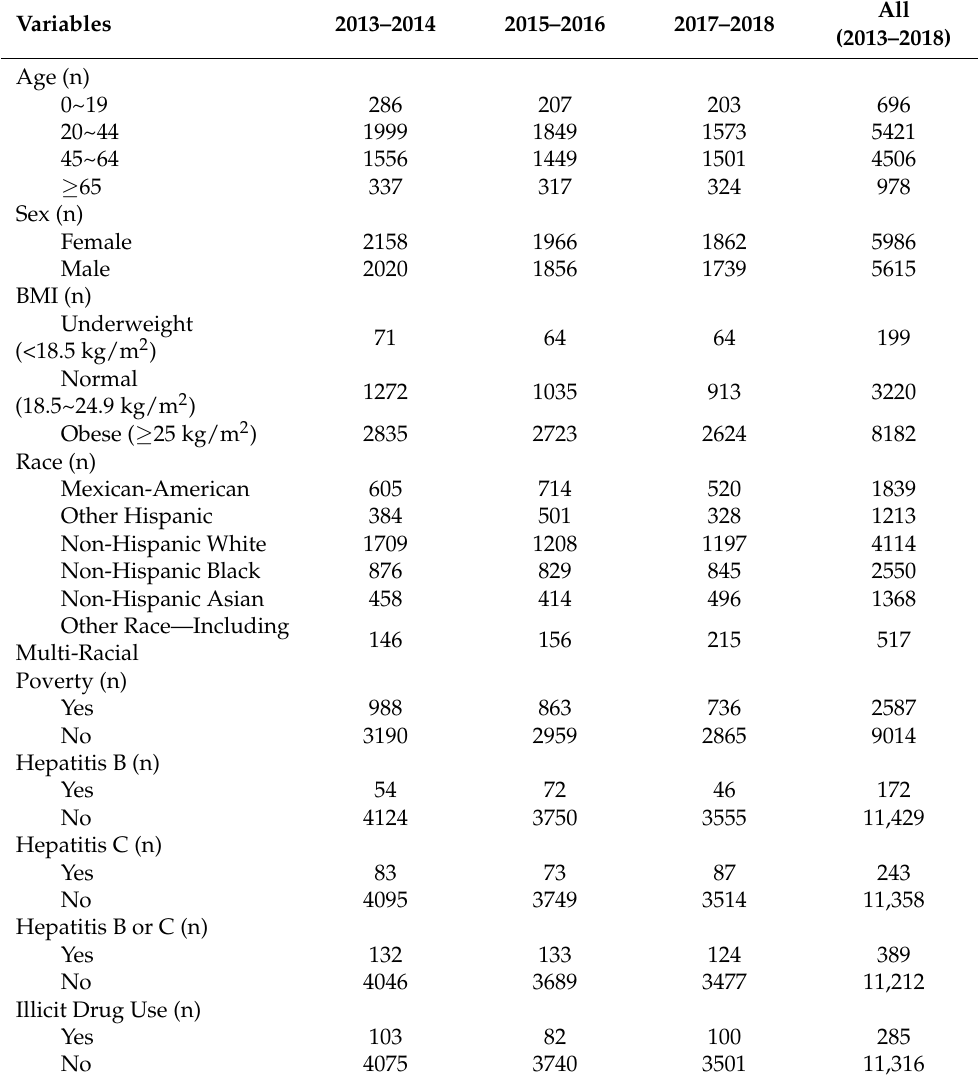
Figure 2. Prevalence of each hepatitis regarding the diabetes mellitus status. DM, diabetes melli- tus; HBV, hepatitis B virus; HCV, hepatitis C virus.